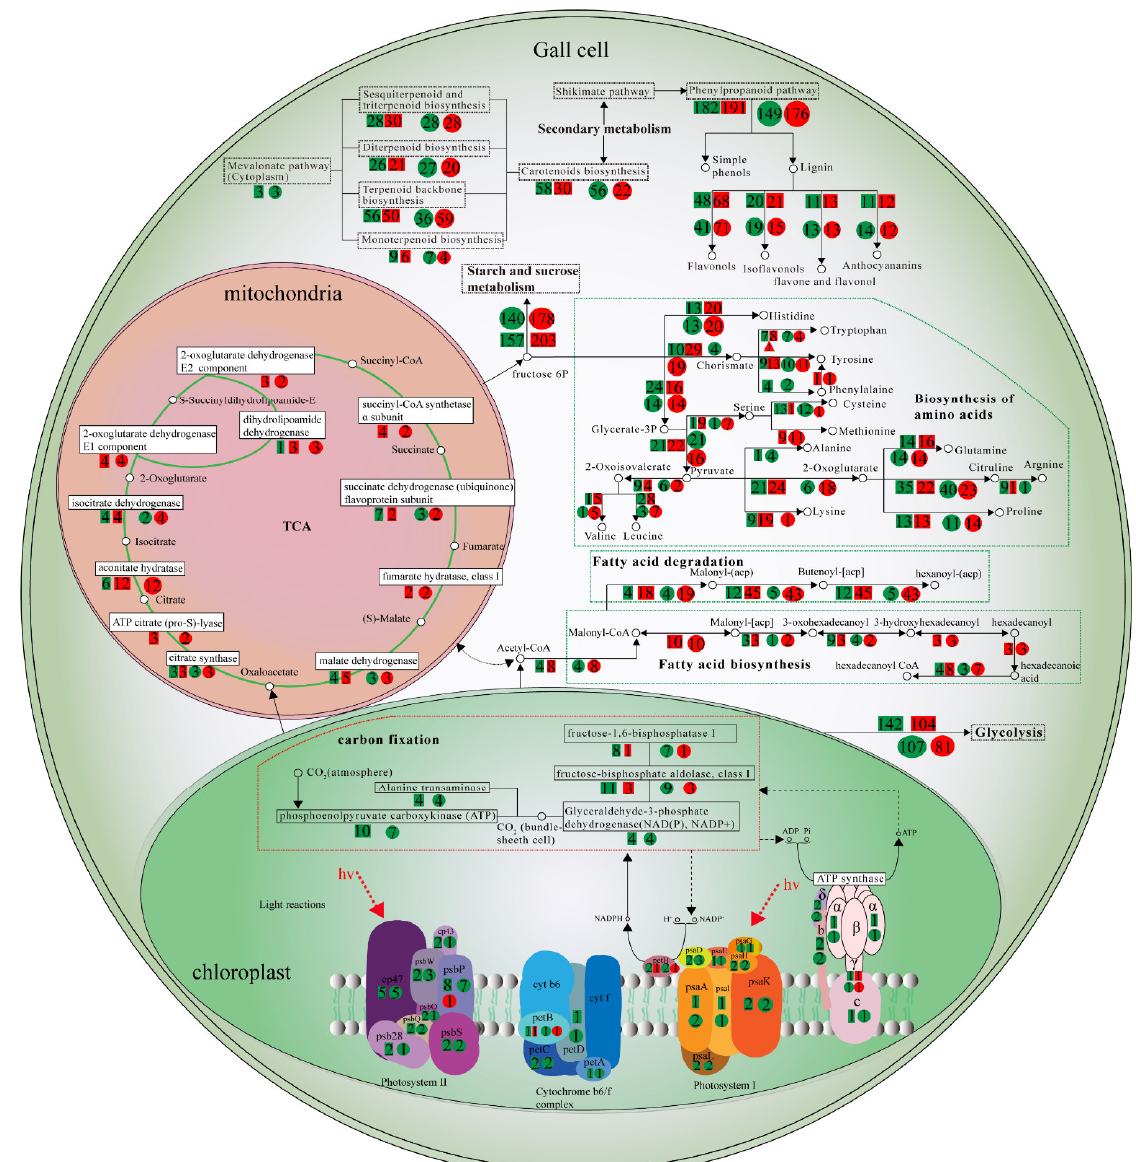
Figure 3. A model of the molecular adaption of horned gall cells based on transcriptomic comparative analyses. Squares indicate comparison between gall vs. LWG, circles indicate comparison between gall vs. LNG, red color indicates up- regulation, and green indicates down-regulation. Arabic numerals represent the number of genes. For photosynthesis, most subpathways were down-regulated, and phosphoenolpyruvate carboxykinase was among the most down-regulated genes for carbon fixation. Although most genes involved in the TCA cycle were up-regulated, the genes encoding succin- ate dehydrogenase (ubiquinone) were down-regulated. Genes for biosynthesis of essential amino acids for insects were up-regulated (histidine, leucine, lysine, methionine, tryptophan, valine), except for the genes involved in the synthesis of phenylalaine and arginine. Genes for biosynthesis of nonessential amino acids (cysteine, citruline) for insects were down- regulated. Genes involved in the production of secondary metabolites such as flavonols were generally up-regulated. Genes for photosynthesis were generally inhibited compared with control leaf tissues (Figures 2e and A5). In particular, genes encoding components in the carbon fixation were expressed at significantly lower levels (Figures 2f, 3 and A6).